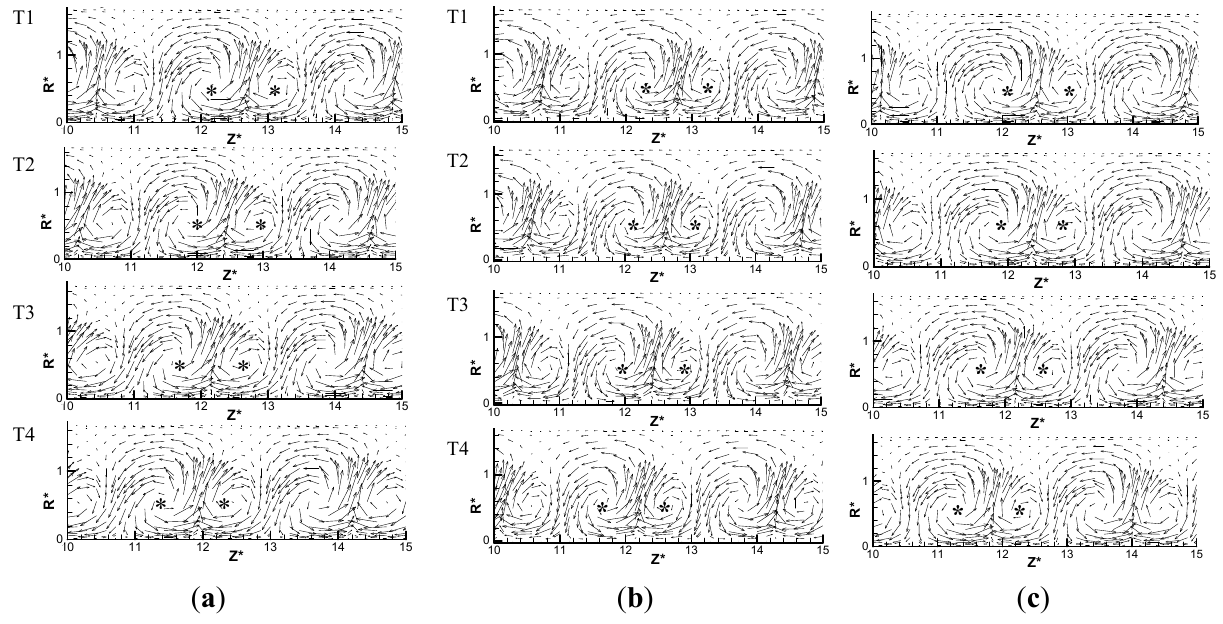
Figure 13. Instantaneous velocity fields in slit models at Re = 110: ( a ) 12-slit model; ( b ) 6-slit model; ( c ) 9-slit model.